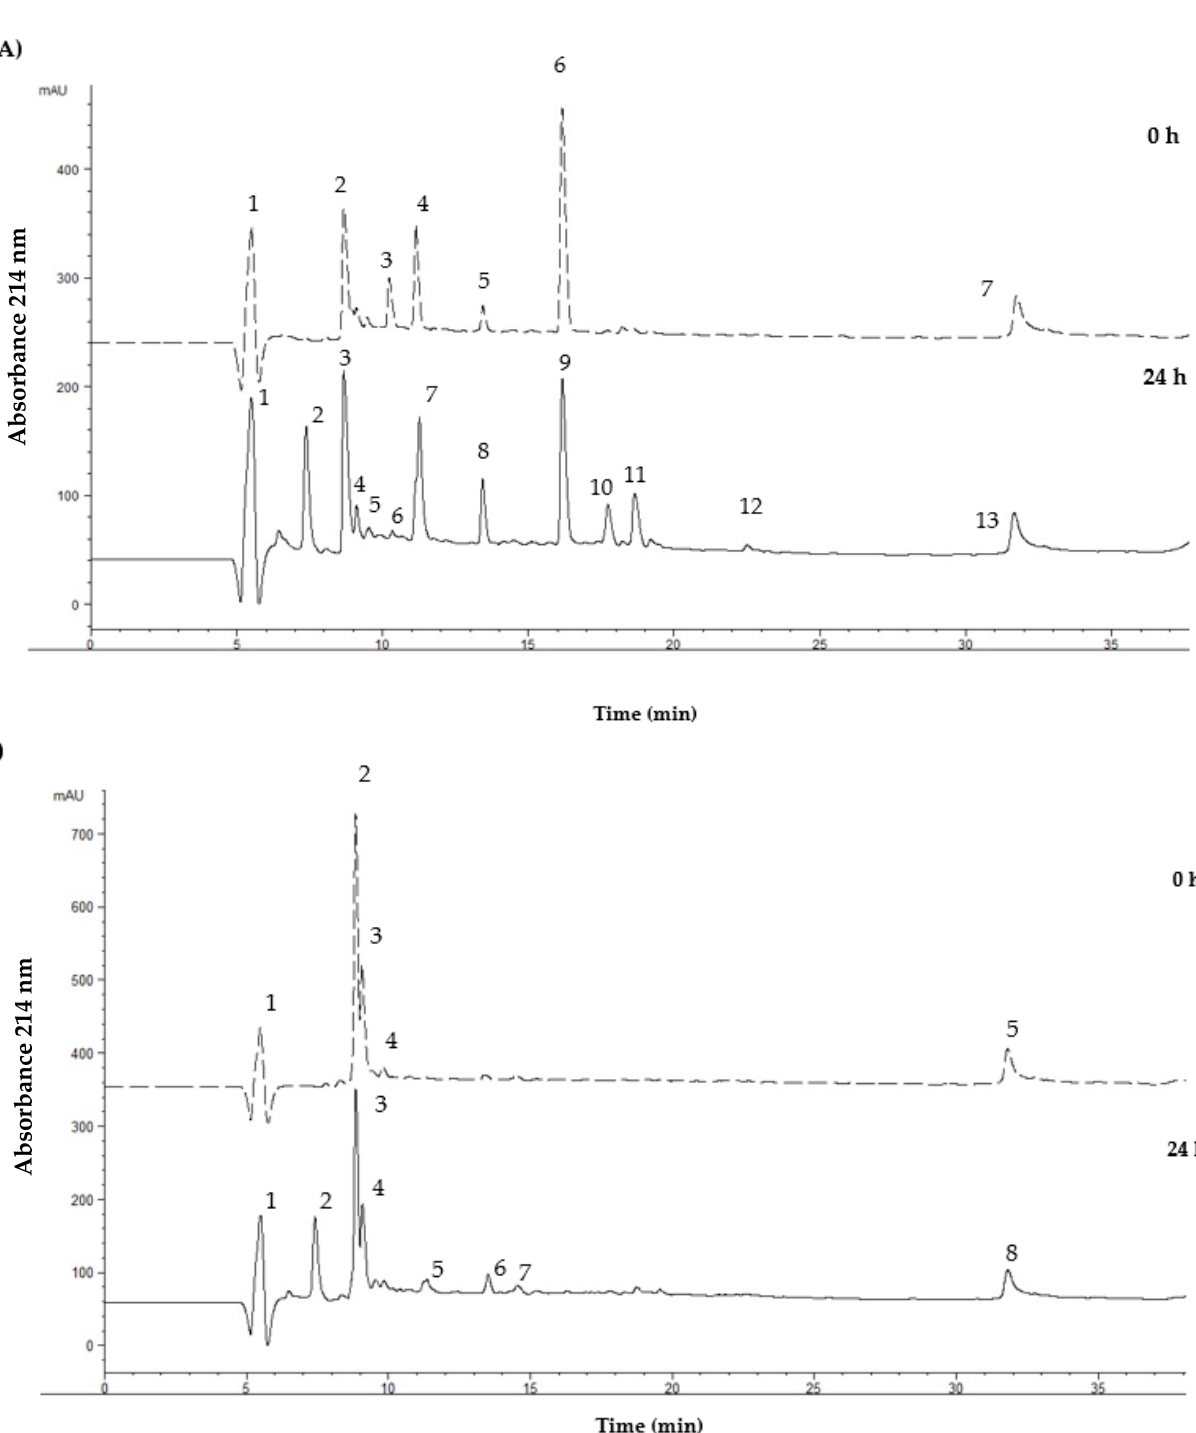
Figure 3. Peptide profiles of the <3 kDa fraction obtained from the fermented insect flour samples fermented by L. lactis NRRLB- 50572. ( A ) The peptide profile for mealworm flour; ( B ) the peptide profile for grasshopper flour.